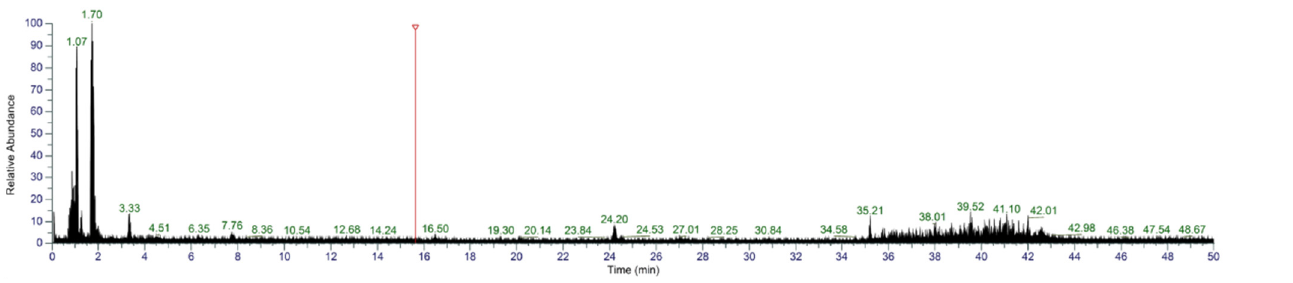
Figure 9. MS/MS spectra of